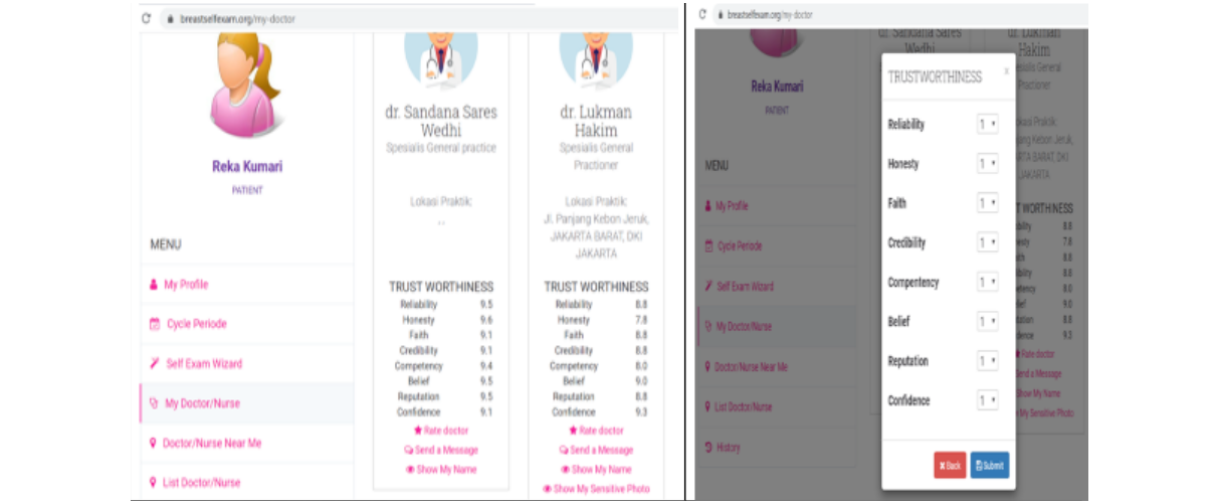
Figure 3. Left: Patient rated two physician after interaction; Right: Trustworthiness scale.